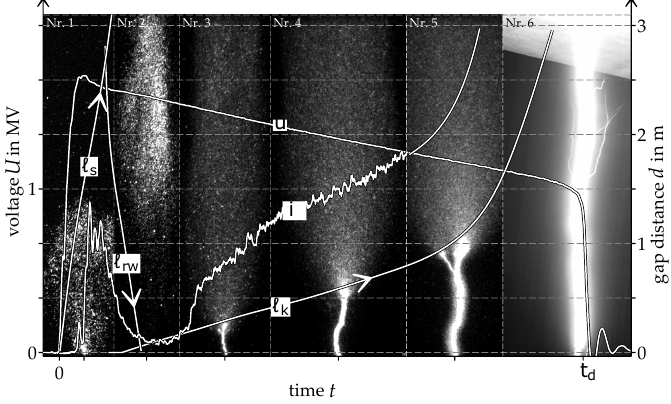
Figure 6. Electrical and optical time characteristics out of